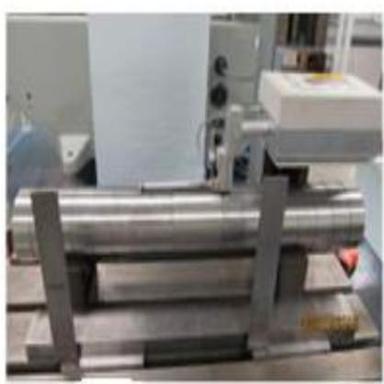
Measuring surface roughness using Taylor Hobson Surtronic 3+.